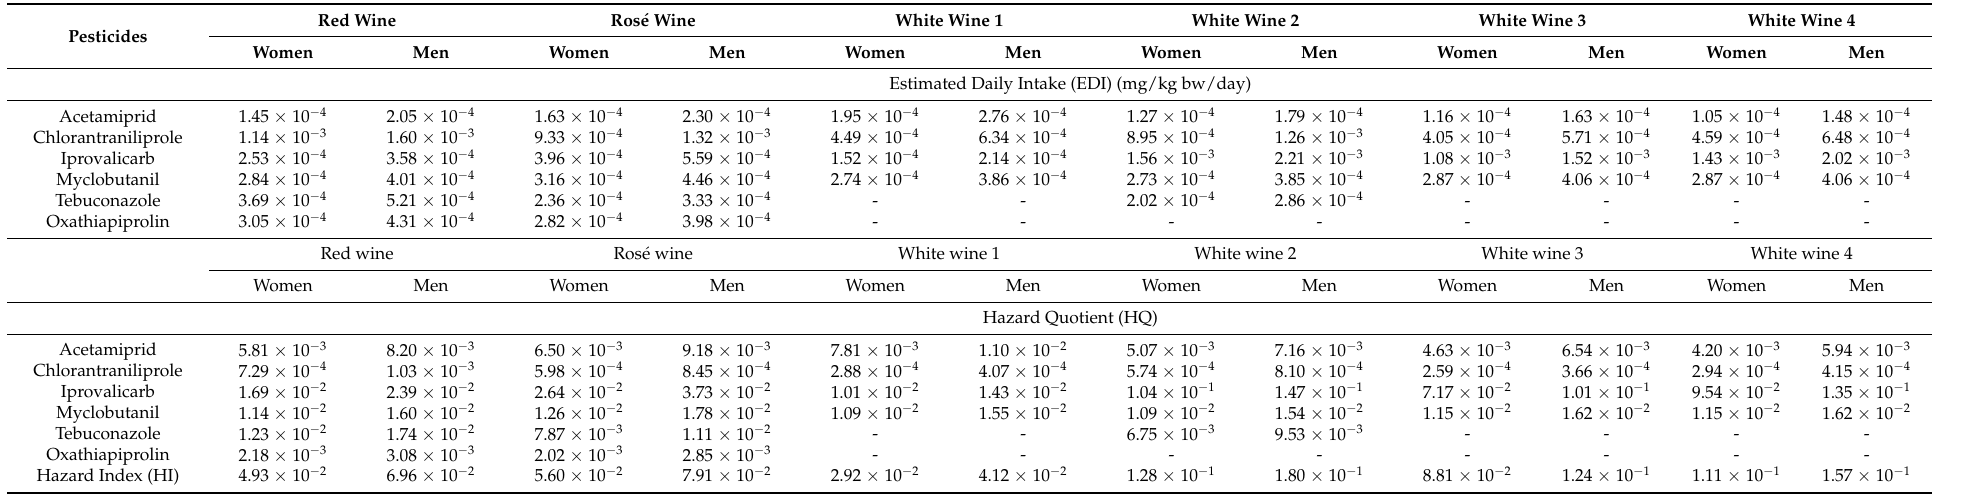
Table 4. The estimated daily intake and hazard quotient in the red, ros é , and white